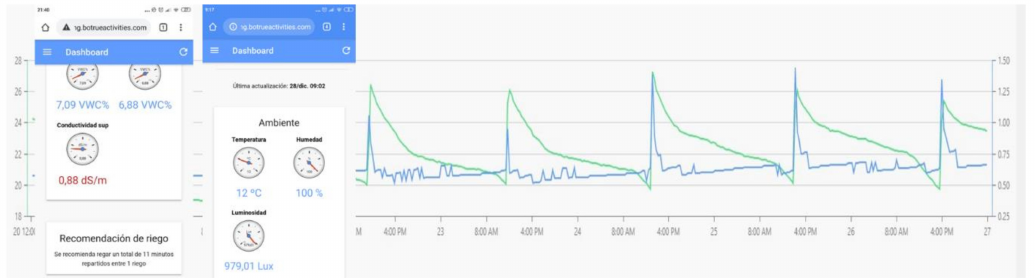
Figure 8. User interface of the application